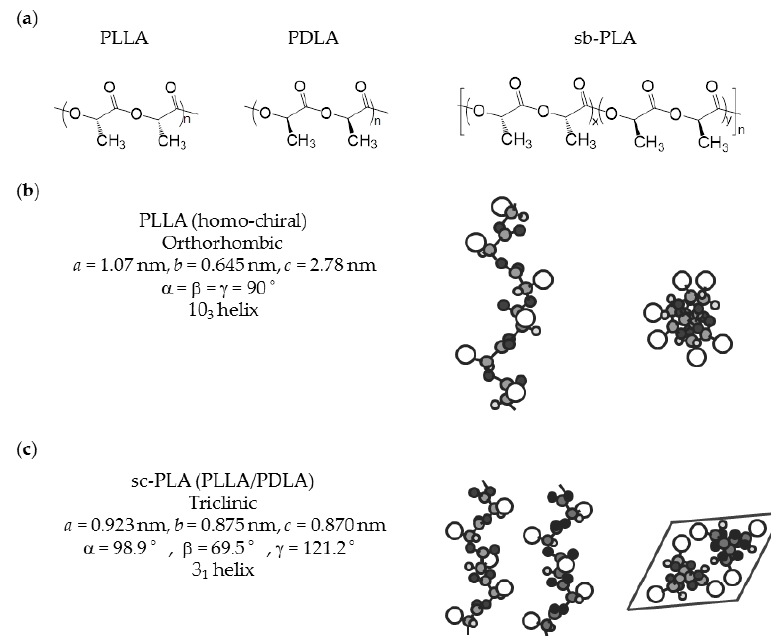
Figure 1. Chemical structures and conformation of PLA: ( a ) chemical structures and chirality; ( b ) conformation of PLLA (homo-chiral) [33]; and ( c ) conformation of sc-PLA from a combination of PLLA and PDLA [34].